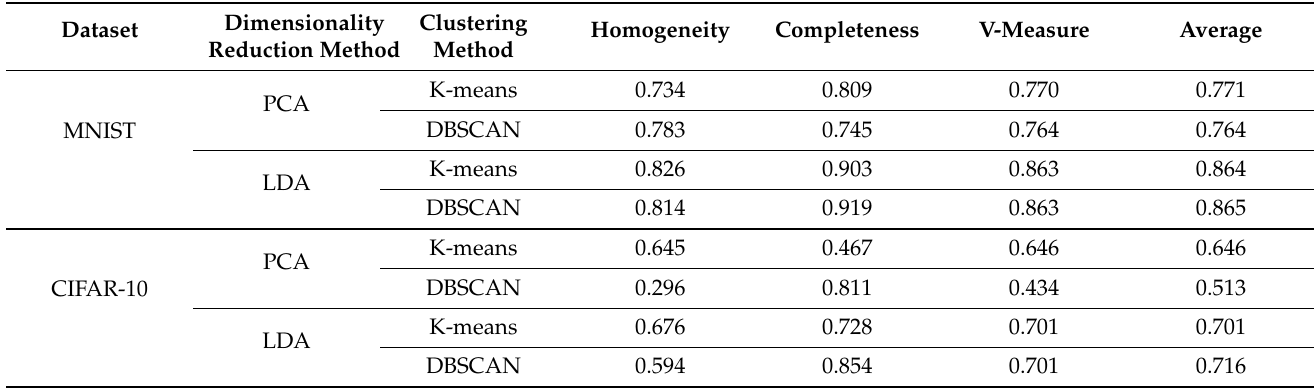
Table 3. Experimental results of the proposed method with the various combinations of dimensional- ity reduction methods and clustering methods.